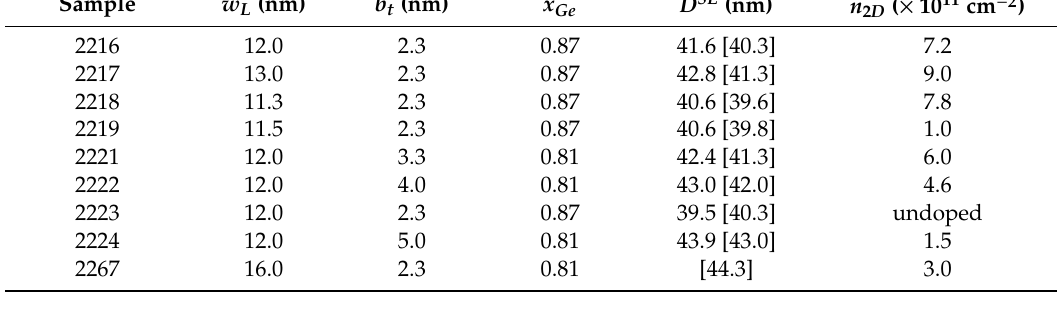
Table 1. Asymmetric coupled quantum well (ACQW) design. b t is the thickness of the tunnel barrier and x Ge its composition. w L is the thickness of the wide well which is n -doped, except for sample 2223. For all the samples, the thin well is 5 nm thick, the ACQW module is repeated 20 times and the Si 0.20 Ge 0.80 spacer thickness between the modules is 21 nm. The multi-quantum well (MQW) periodicity D SL is measured from the spacing of the superlattice fringes in X-ray di ff raction (XRD) rocking curves. Values in brackets are the nominal periodicities. The sheet carrier density n 2 D is obtained from the Fourier transform infrared (FTIR) optical absorption spectra α 2D ( ω ). Sample